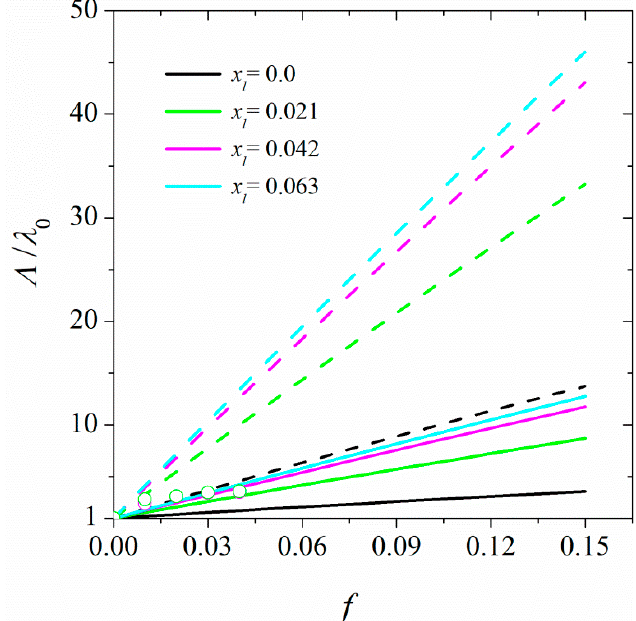
Figure 10. Dependence of the thermal conductivities of nanocomposite, Λ , at different linkage fractions, shown in the figure’s legend, on the volume fraction of CNT (17, 0). The full and dashed curves represent thermal conductivities for CNTs of length 1 and 5 µ m, respectively. The markers represent the experimental data by Li et al. [42] on the thermal conductivity of functionalized CNT polymer nanocomposites.